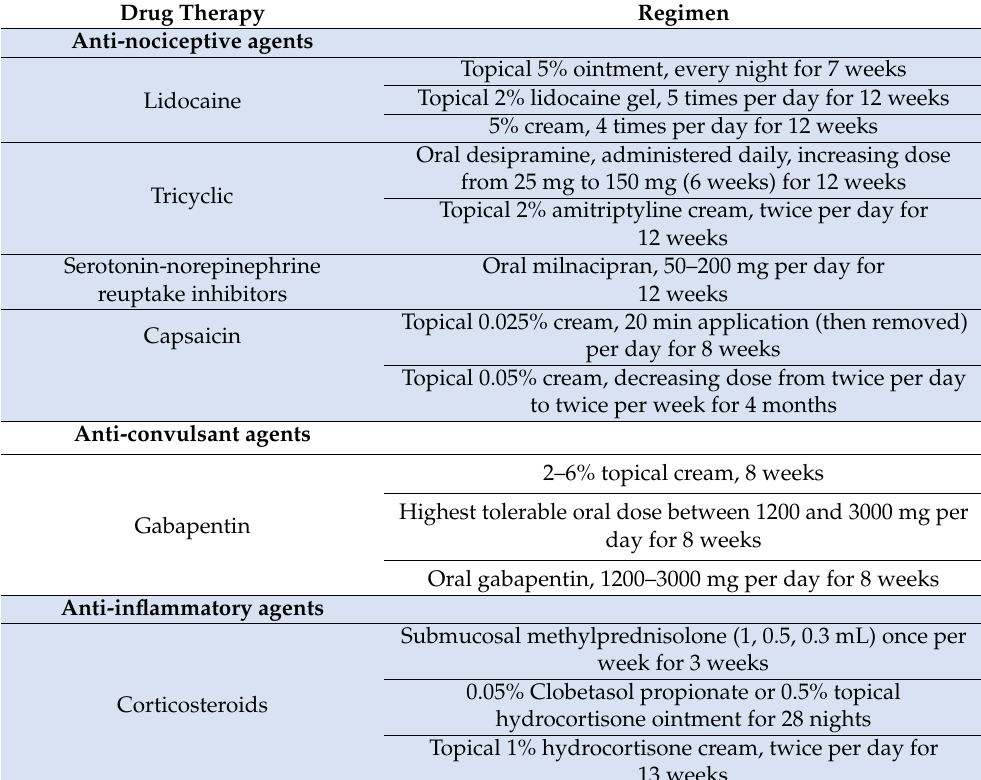
Table 1. This table describes the drugs used in the treatment of vulvodynia with the respective therapeutic regimens most frequent in the